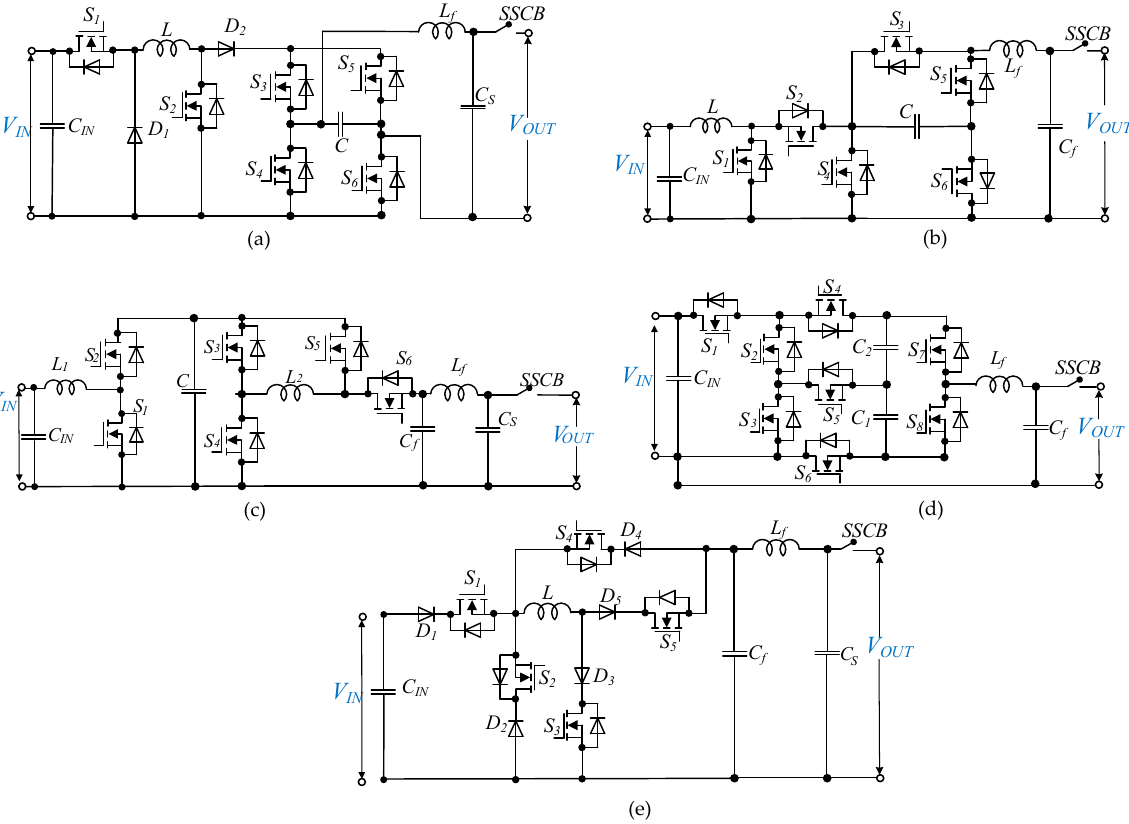
Figure 4. Schematics of the compared topologies: ( a ) buck–boost and the unfolding circuit in [9], ( b ) FC power converter in [25], ( c ) FI power converter in [27], ( d ) SC power converter in [24], and ( e ) FI power converter in [29].